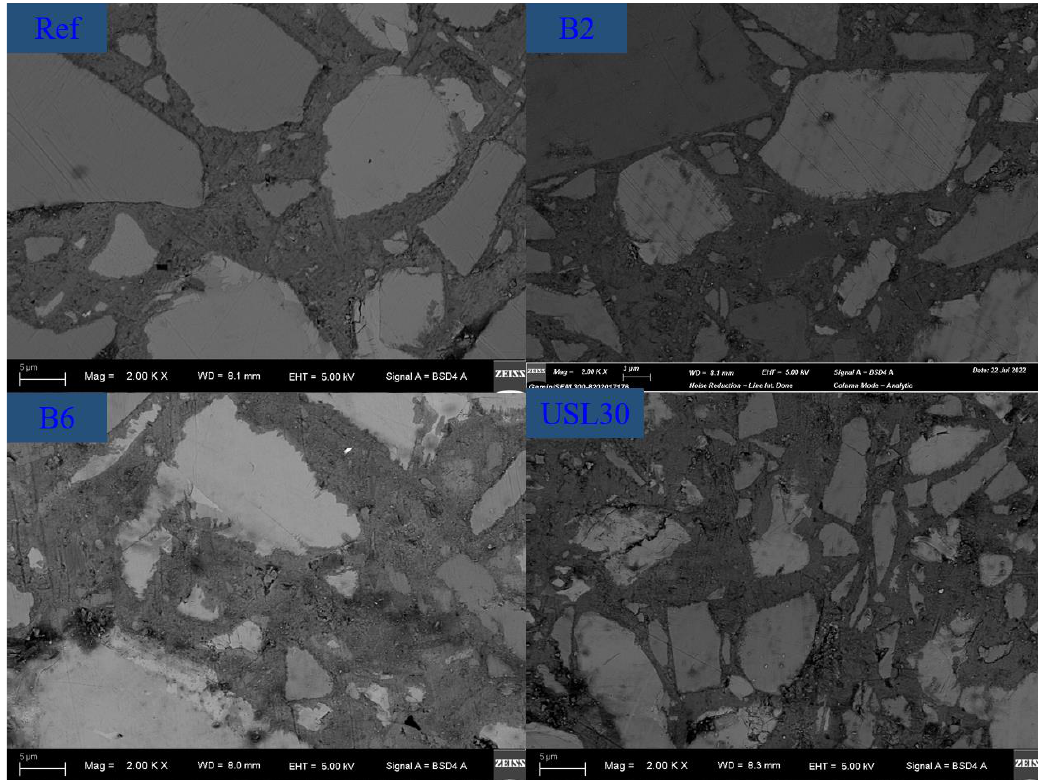
Figure 10. BSE images of the Ref, B2, B6, and USL30 pastes at 28